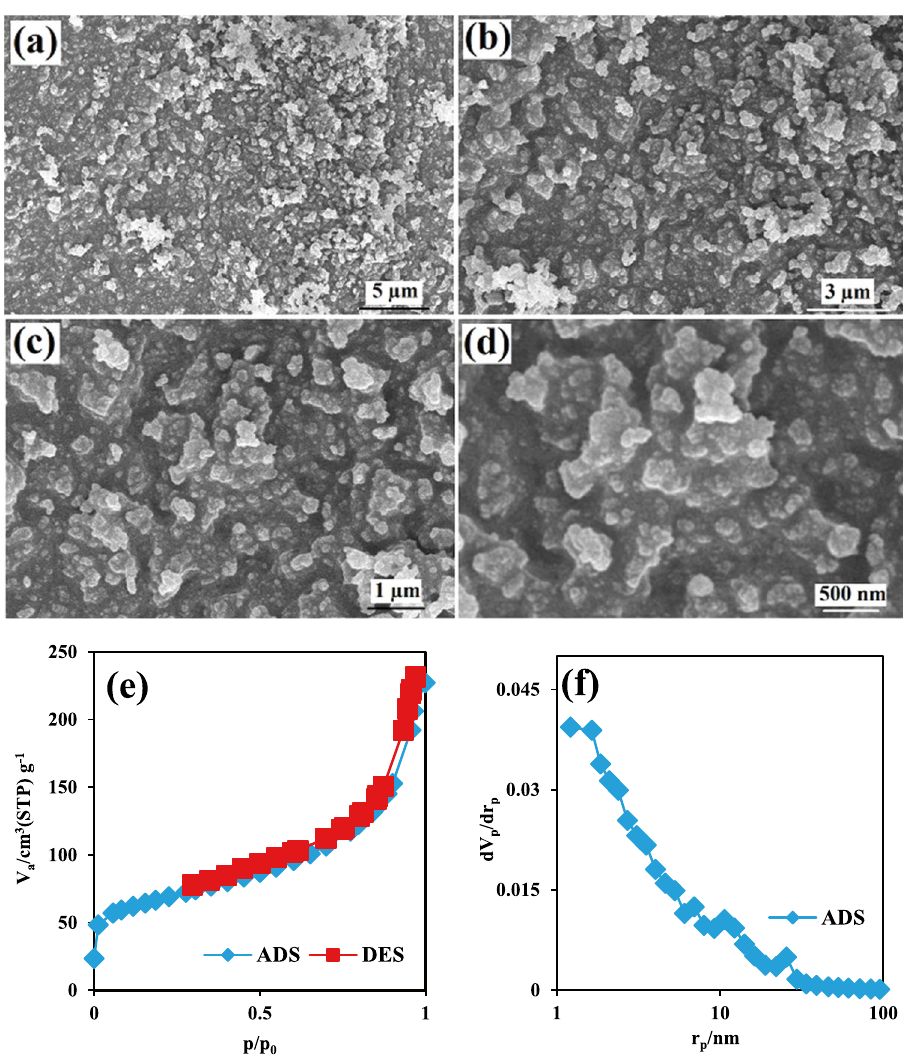
Figure 4. FESEM images of MIL-68(Al) with different magnifications ( a – d ); The ADS/DES isotherm of N 2 on MIL-68(Al) ( e ), BJH pore size of MIL-68(Al) ( f